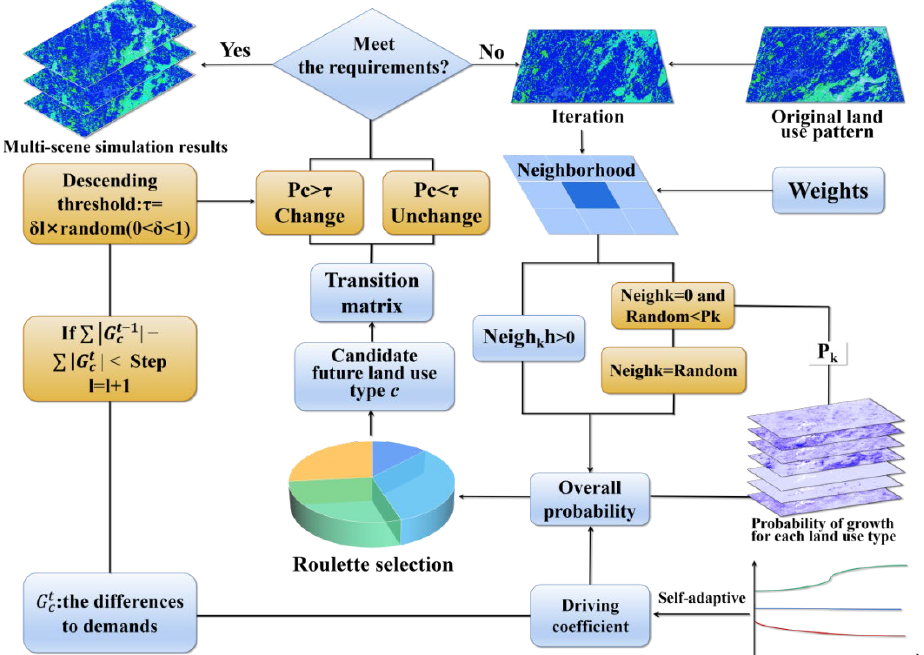
Figure 3. CA model based on multi-class random patch seed (CARS).